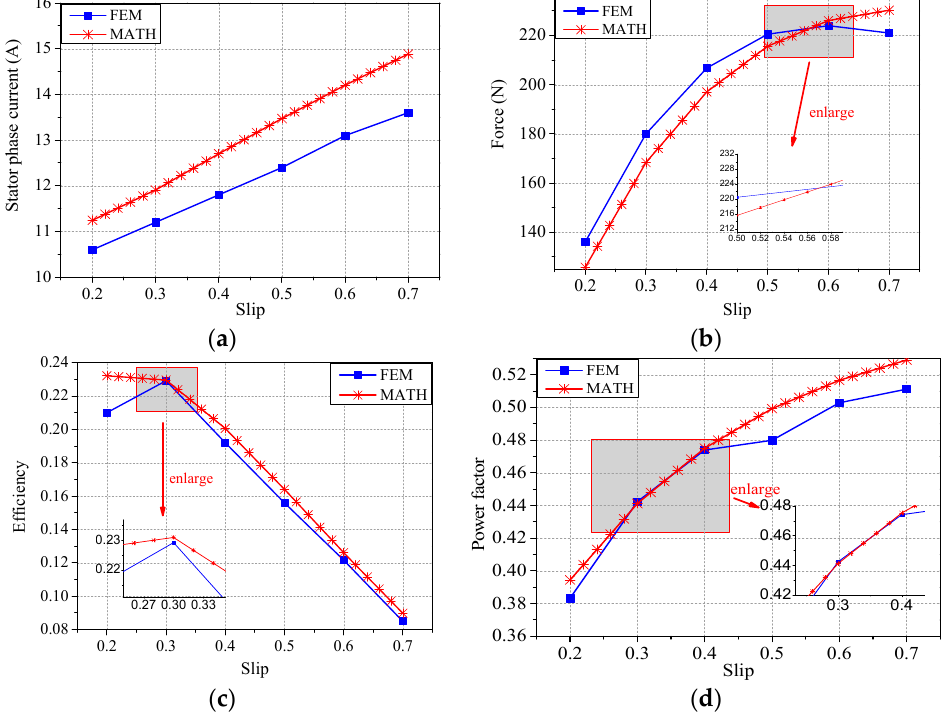
Figure 13. Characteristics of the linear part: ( a ) Stator phase current; ( b ) Force; ( c ) Efficiency; ( d ) Power factor. Table 5. Stator phase current and force.